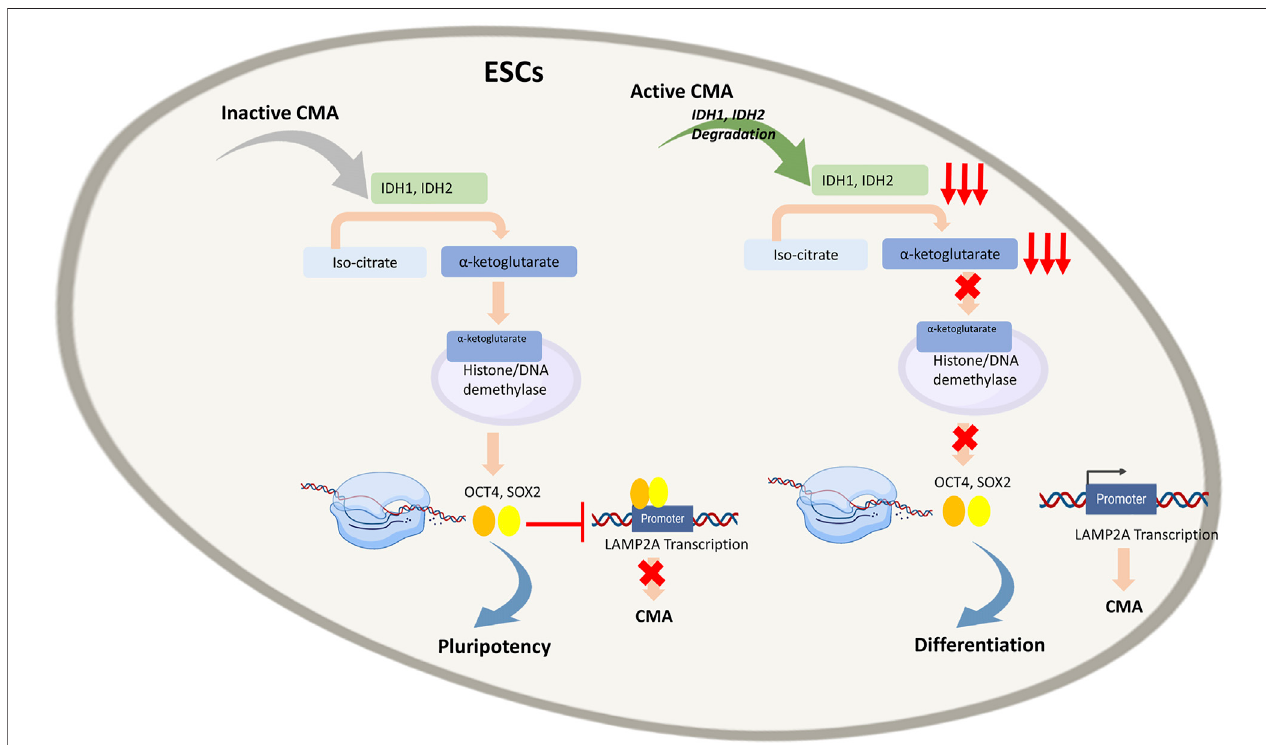
FIGURE 4 | Regulation of Embryonic stem cells (ESCs) by Chaperone-Mediated Autophagy (CMA): In quiescent ESCs, where CMA is inactive, Isocitrate dehydrogenases (IDH)1 and IDH2 convert isocitrate to α -ketoglutarate, a cofactor of numerous histones and DNA demethylases. Through epigenetic control, it enables expression of transcription factors OCT4 and SOX4 that bind to LAMP2A promoter and inhibit transcription of LAMP2A gene and subsequently of CMA that in turn enablestomaintainpluripotencyofESCs.InactiveESCs,CMAleadstodegradationofIDH1andIDH2,resultinginlow α -ketoglutaratelevelsandconsequentlylow OCT4 and SOX4 expression, enabling LAMP2A transcription. This activates CMA that in turn empowers differentiation of ESCs.